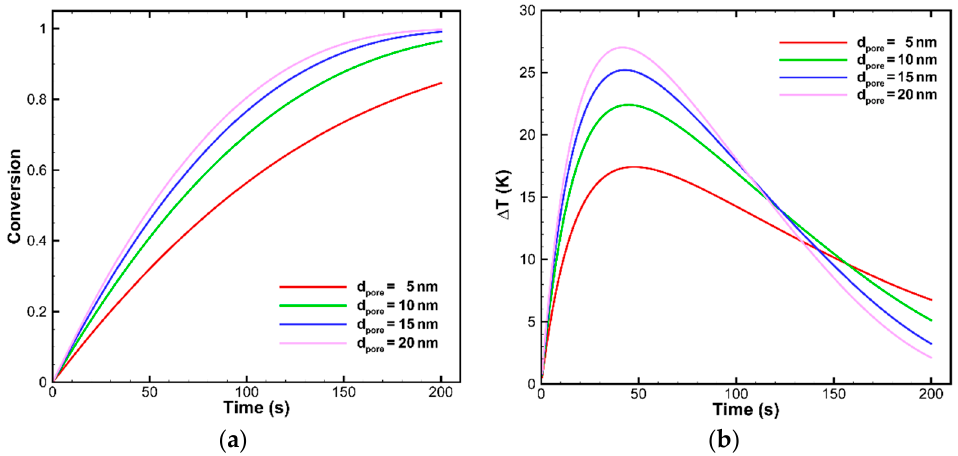
Figure 4. The profiles of ( a ) overall conversion and ( b ) ∆ T at various particle pores size over time. Oxygen Carrier Load